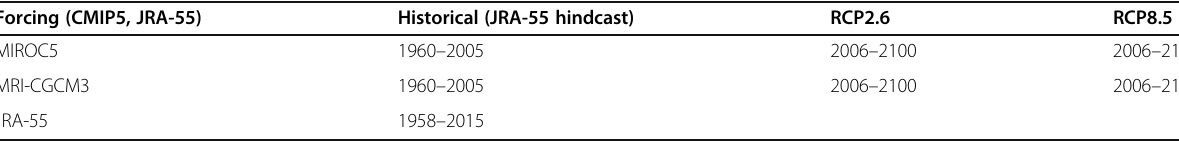
Table 3 Periods of historical and future projection experiments by the NP10 Forcing (CMIP5, JRA-55) Historical (JRA-55 hindcast)